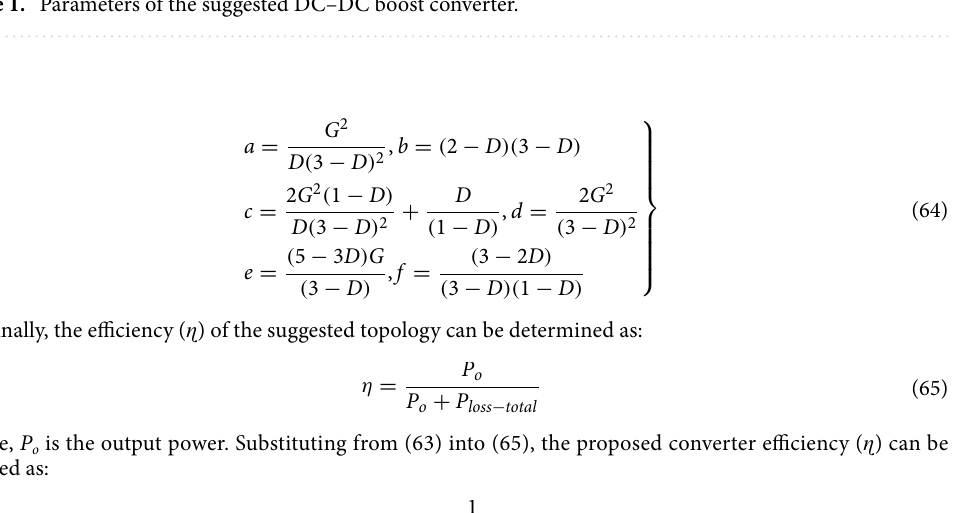
Table 1. Parameters of the suggested DC–DC boost